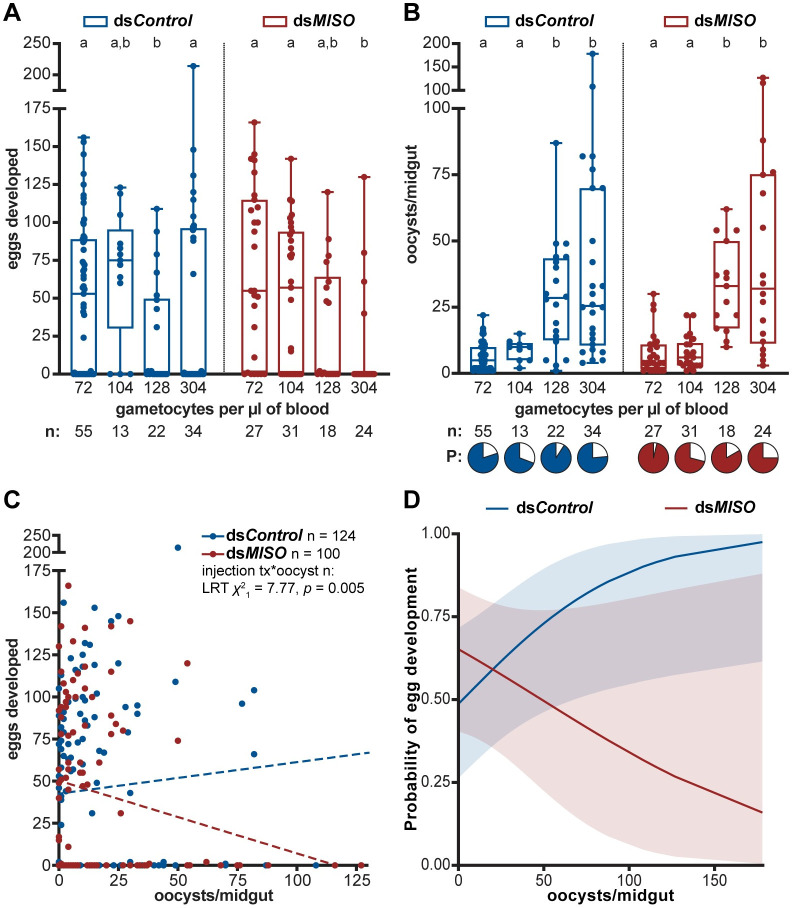
MISO enforces tolerance to P. falciparum in field infections with gametocyte carriers.(A) The number of eggs developed by An. coluzzii females silenced for MISO (dsMISO) is negatively impacted by P. falciparum infections with high gametocytemias, while this effect is not observed in dsControl mosquitoes (treatment*gametocytemia: LRT X23 = 16.15, p = 0.001). Four gametocytemias were tested (see S2 Table), with each dot representing paired egg-gametocytemia data for one female. (B) Both dsControl and dsMISO females harbor more oocysts when they are fed with higher gametocytemia blood meals (gametocytemia: LRT X23 = 20.36, p < 0.001), with no impact of MISO silencing (treatment: LRT X21 = 0.85, p = 0.36; treatment*gametocytemia: LRT X23 = 0.85, p = 0.84). P. falciparum prevalence (P, pie charts) is not affected by gametocytemia or MISO silencing (gametocytemia: LRT X23 = 5.78, p = 0.12; treatment: LRT X21 = 0.60, p = 0.44; treatment*gametocytemia: LRT X23 = 4.63, p = 0.20). Each dot represents paired oocyst-gametocytemia data for one female. For both A and B, data are represented as box and whisker plots with minimum and maximum values. Pairwise comparisons (letters) are computed via estimated marginal means. In B, females that developed no oocysts are omitted from the dot plots to represent intensity of infection. (C)
MISO silencing breaks the interaction between egg and oocyst development, with higher oocyst intensities leading to fewer numbers of eggs developed (treatment*oocyst number: LRT X21 = 7.77, p = 0.005). Each dot represents paired egg-oocyst data for one female. One data point for dsControl (178, 88) is excluded from the graph to simplify data visualization. Dotted regression lines represent data trends only. tx = treatment, n = number, * = interaction. (D) While in control females the probability of egg development increases as oocyst intensity increases, MISO-silenced females have a lower likelihood of egg development as infection burden increases (treatment*oocyst number: LRT X21 = 7.18, p = 0.007). Curves represent the probability of egg development given x number of oocysts, with shading indicating 95% confidence intervals. In all panels, n represents sample size. All panels in this figure come from data collected from three independent replicates.